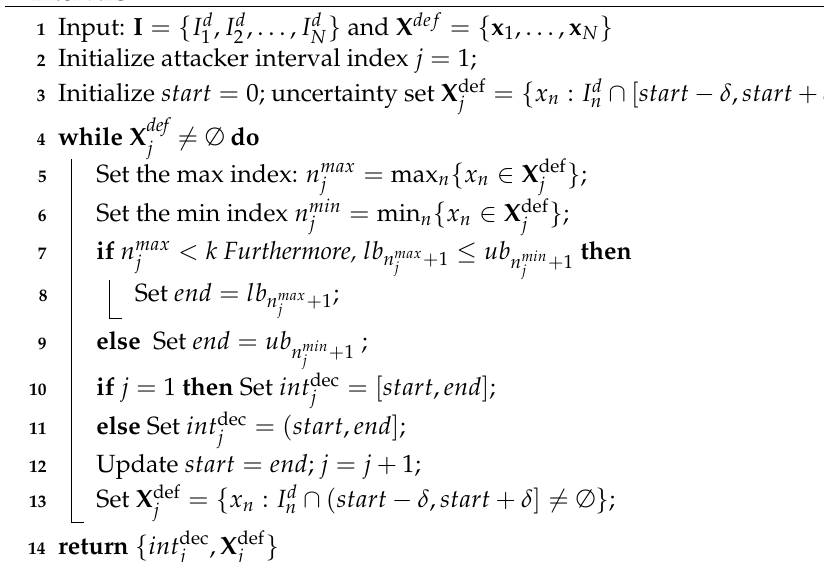
Algorithm 2: Counter-deception—Decomposition of QR parameter into sub-